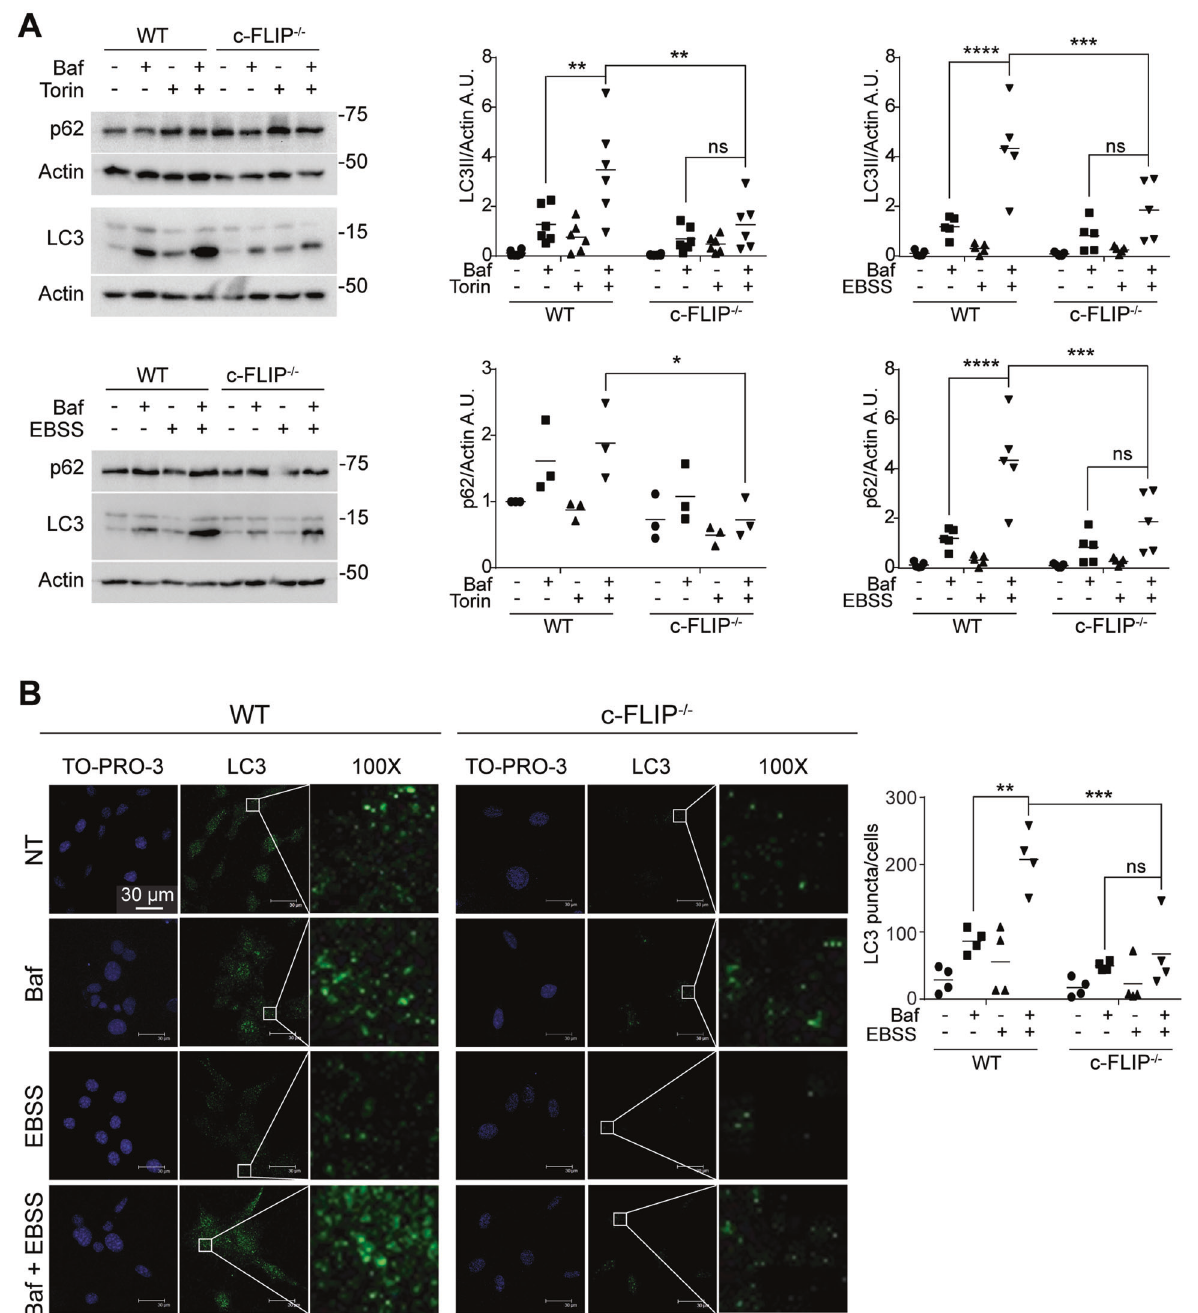
Fig. 1 Autophagic fl ux is compromised in c-FLIP − / − cells. A WT and c-FLIP − / − MEFs were treated with torin 1 (Tor) (250 nM) and ba fi lomycin A1 (Baf) (100 nM) or cultured in a starvation medium (EBSS) and treated with ba fi lomycin A1 (Baf) (100 nM) for 3 h. Autophagic fl ux was assessed by measuring LC3 II and p62 protein levels by western blotting. β -Actin was used as a loading control. Data shown are representative of at least three individual experiments. * p < 0.05, ** p < 0.01, *** p < 0.001, **** p < 0.0001 determined by two-way ANOVA. B WT and c-FLIP − / − MEFs were cultured in EBSS and treated with ba fi lomycin A1 for 3 h. Cells were fi xed and stained with anti-LC3 antibody (green) and then analysed by confocal microscopy. The images and the graph shown are representative of at least three individual experiments. ** p < 0.01, *** p < 0.001 determined by two-way ANOVA. Scale bar, 30 μ